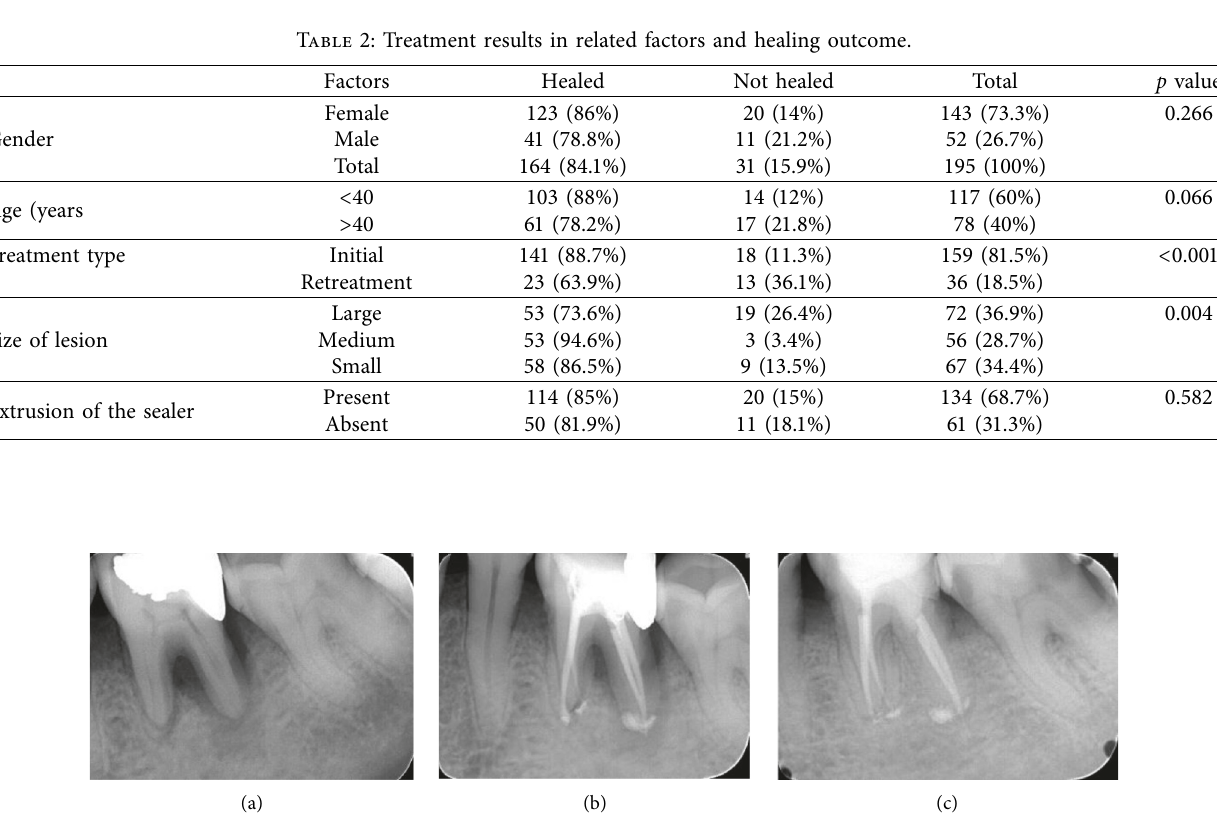
Figure 1: Large size lesion in initial treatment endoperio lesion. A: diagnostic X-ray; B: final obturation; C: 12 month follow-up.